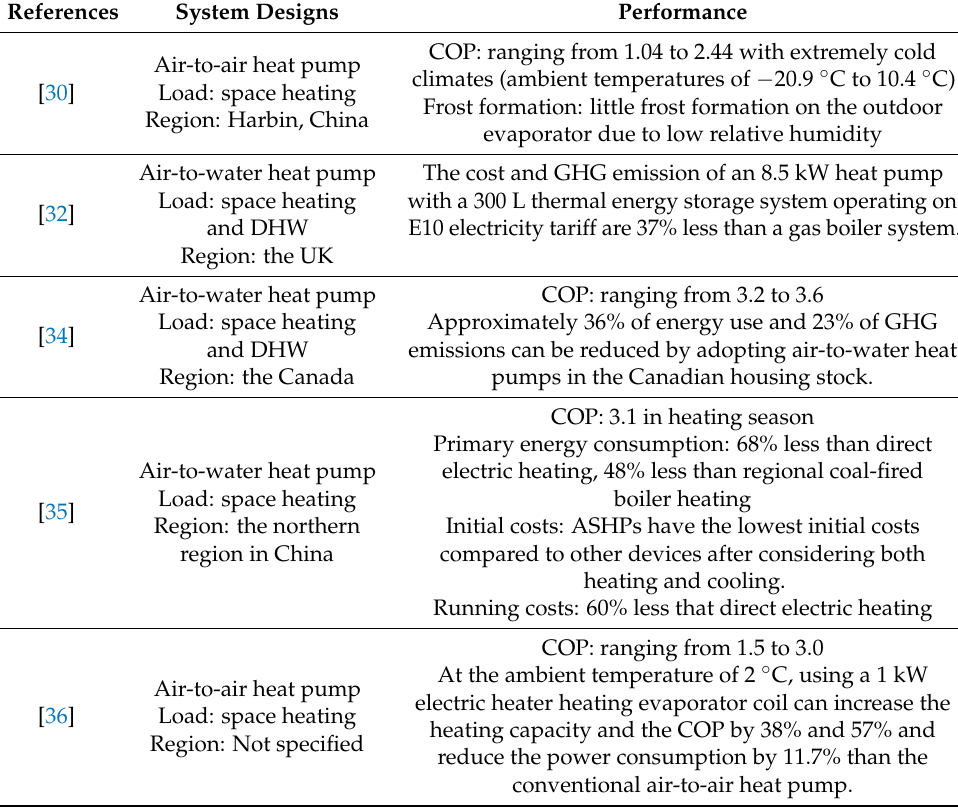
Table 1. Summary of studies of ASHP